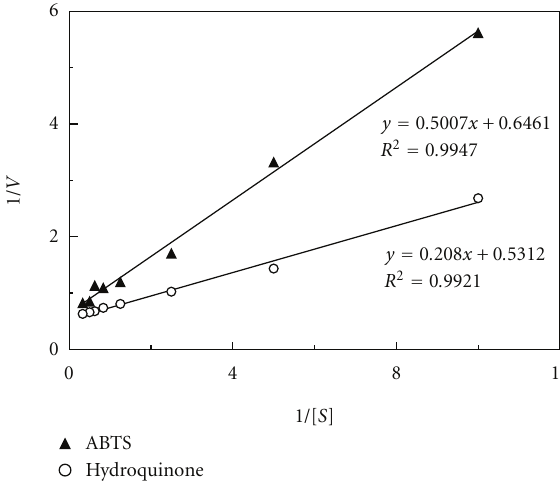
Figure 5: The Lineweaver-Burk plots of A. placomyces